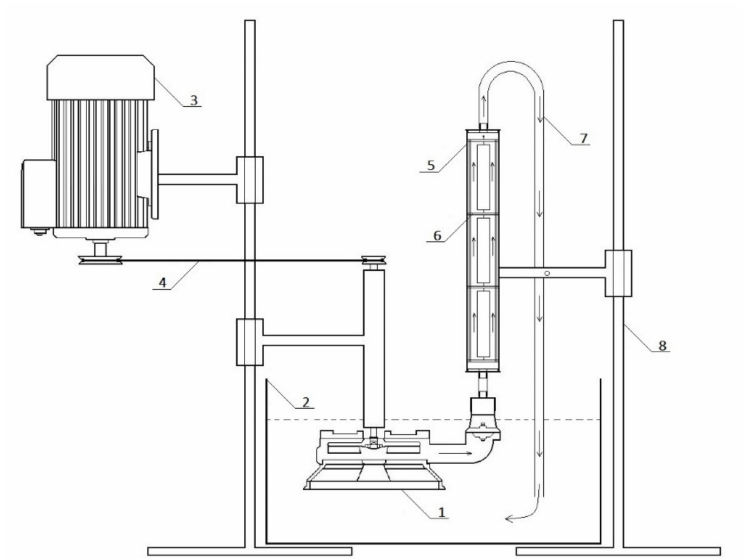
Figure 4. Diagram of the drilling fluid flow simulator. (1) Pump with a centrifugal impeller; (2) tank with drilling fluid; (3) electric motor; (4) drive belt; (5) polyvinyl chloride (PVC) pipe; (6) core holder; (7) drilling fluid supply pipe; (8) tripod.